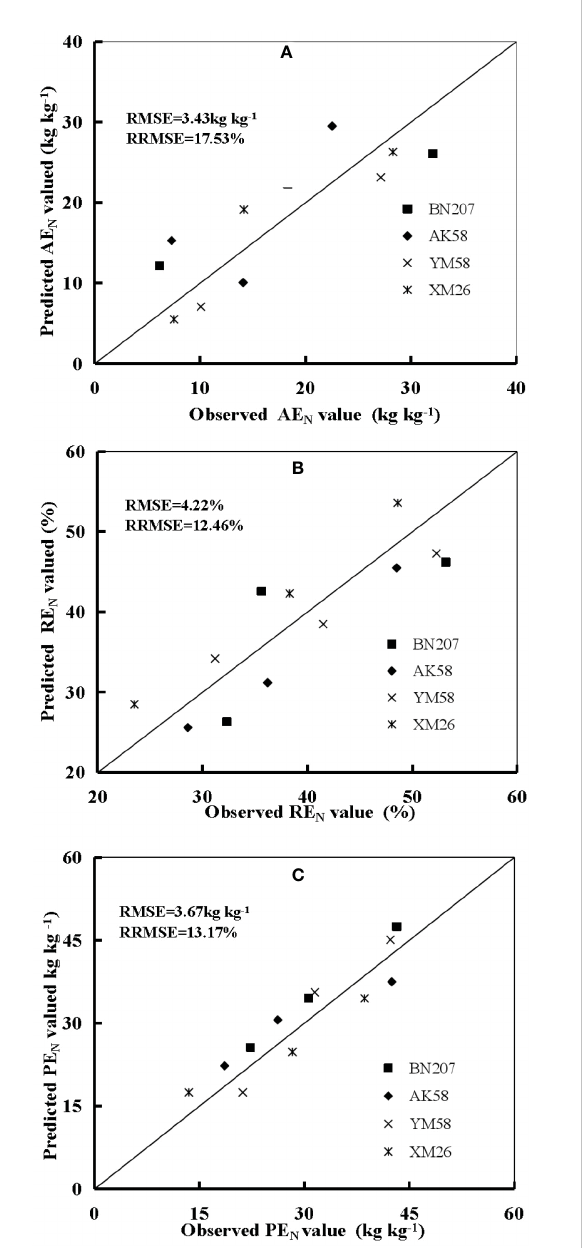
FIGURE 7 Comparison of the observed and predicted difference of AE N (A) , RE N (B) , and PE N (C) values from 2016 to 2017 at Xinxiang and